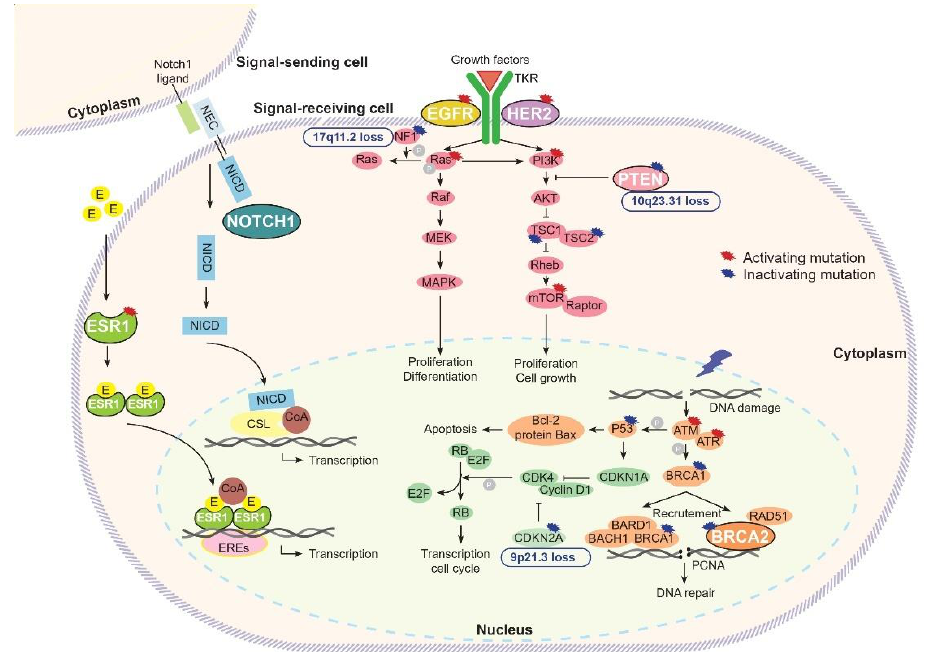
Figure 4. Gene alterations and signaling pathways involved in breast cancer carcinogenesis and brain metastatic processes: estrogen, CoA: coactivators, EREs: estrogen receptor elements, NEC: Notch1 extracellular cell, NICD: Notch1 intracellular cell domain, CSL (CSL proteins): CBF-1/RBPJ- κ in Homo sapiens/Mus musculus, respectively, Suppressor of Hairless in Drosophila melanogaster, Lag-1 in Caenorhabditis elegans, PCNA: proliferating cell nuclear antigen. ESR1 encodes for the estrogen receptor 1 protein. After estrogen binding,